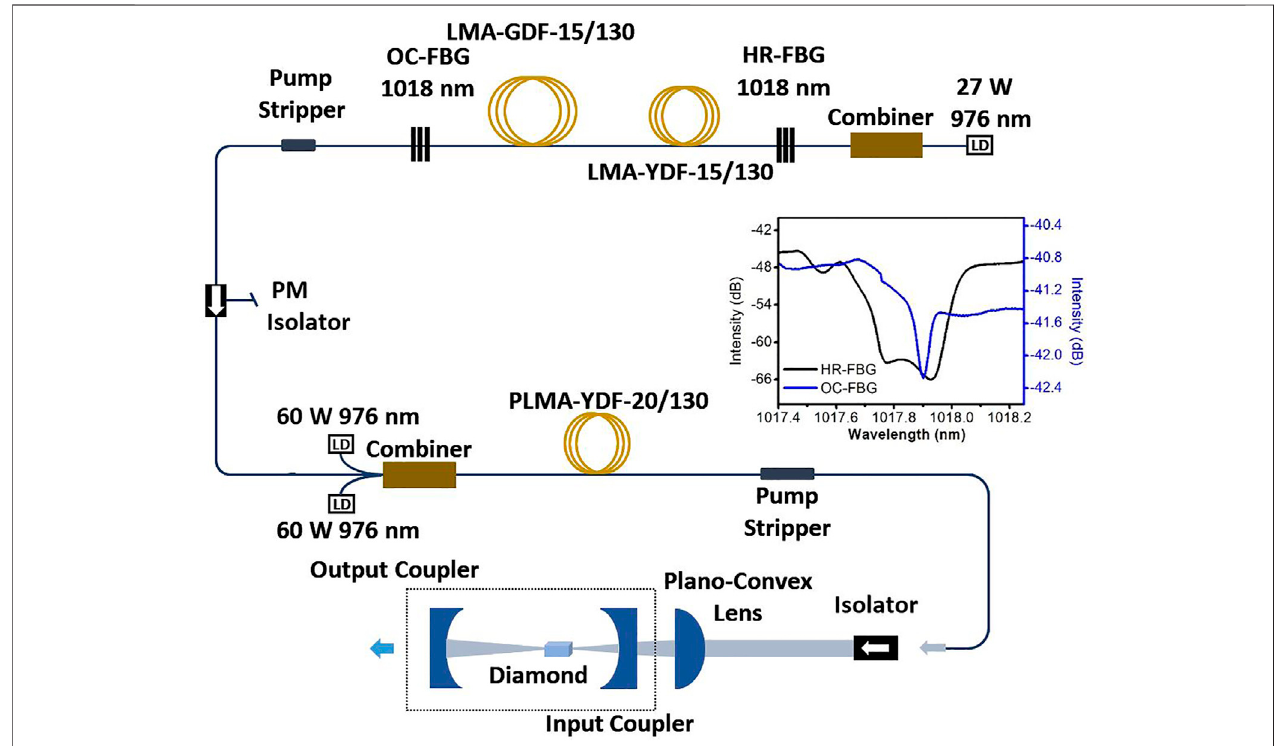
FIGURE1| Diagramof1,018 nm fi berlaserand1,178 nmdiamondRamanlaser(dottedbox).LD:laserdiode;PM:polarizationmaintaining;PLMA:polarizedlarge mode area; YDF: Yb 3+ -doped fi ber; GDF: germanium-doped fi ber; HR FBG: highly re fl ective fi ber Bragg grating; OC FBG: output-coupling fi ber Bragg grating; 15/130 and 20/130: fi ber core diameter of 15 or 20 μ m, and a fi ber-cladding diameter of 130 μ m. The inset is the transmission spectra of HR (black) and OC (blue) FBGs.